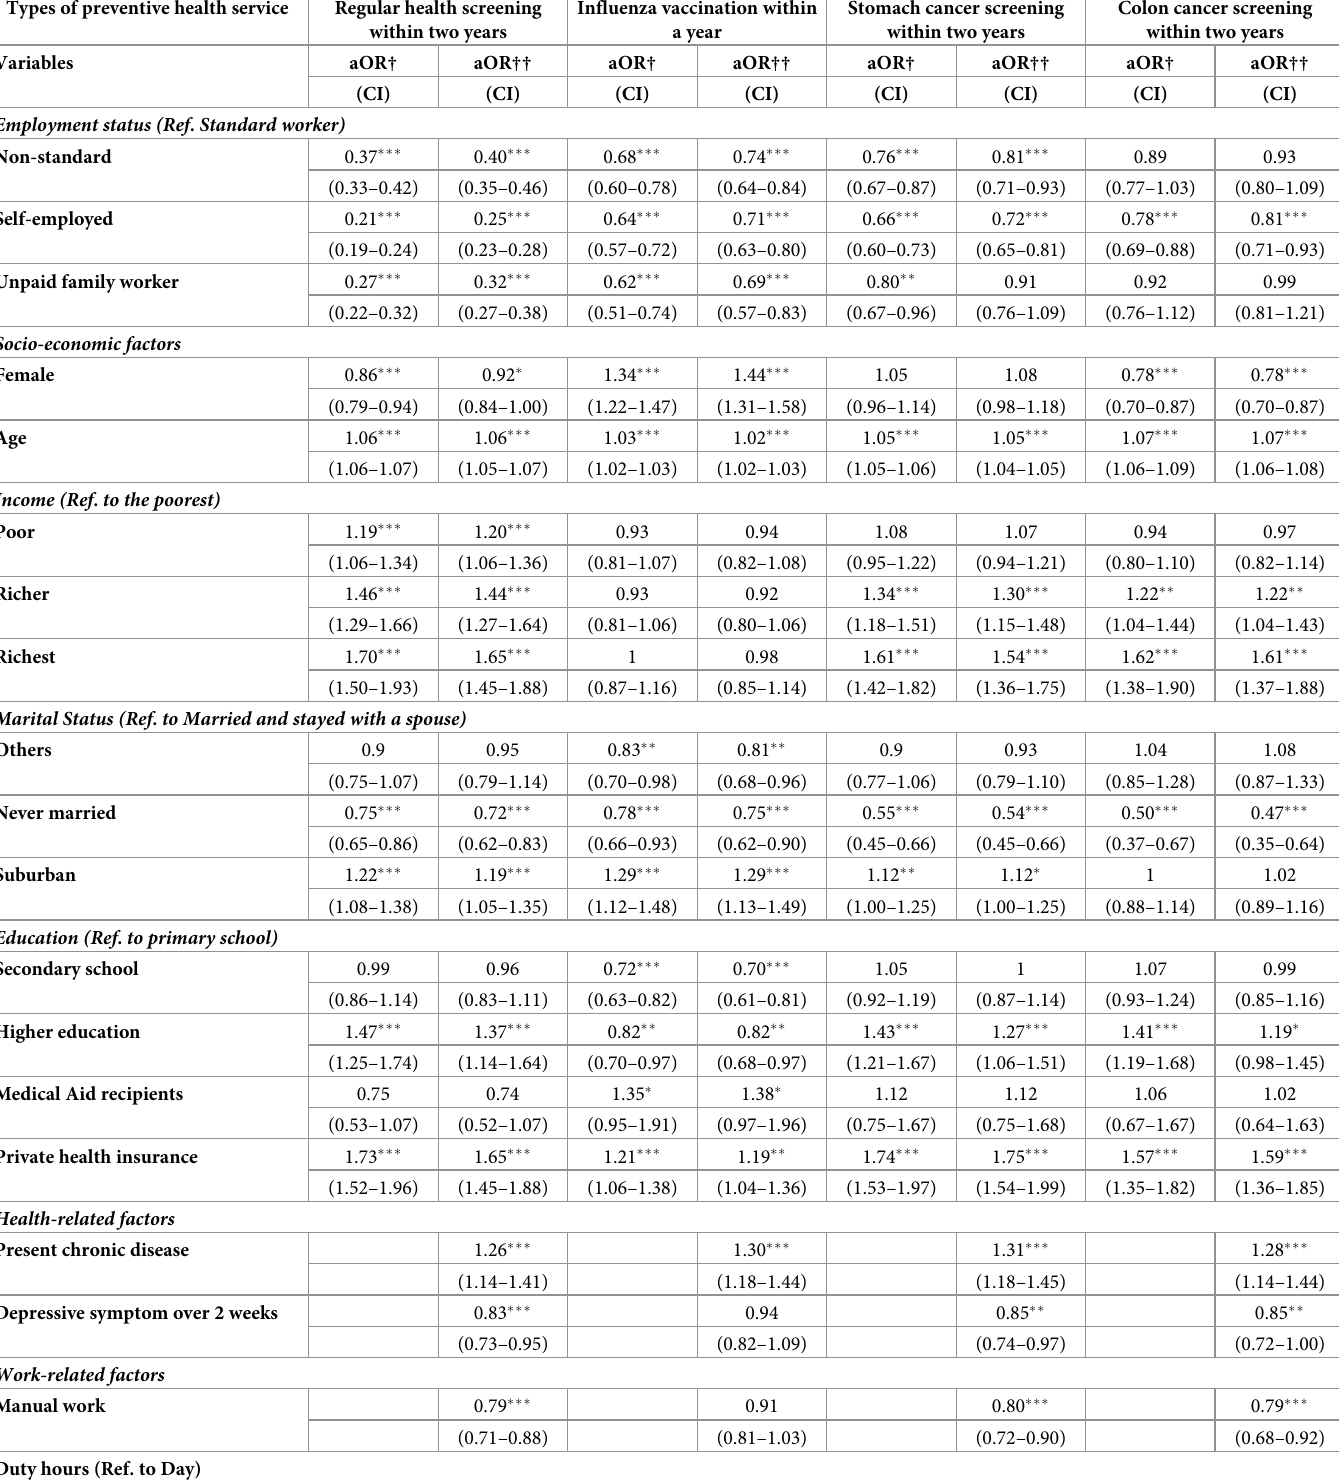
Table 4. Logistic regression analyses of four preventive health services for both male and female